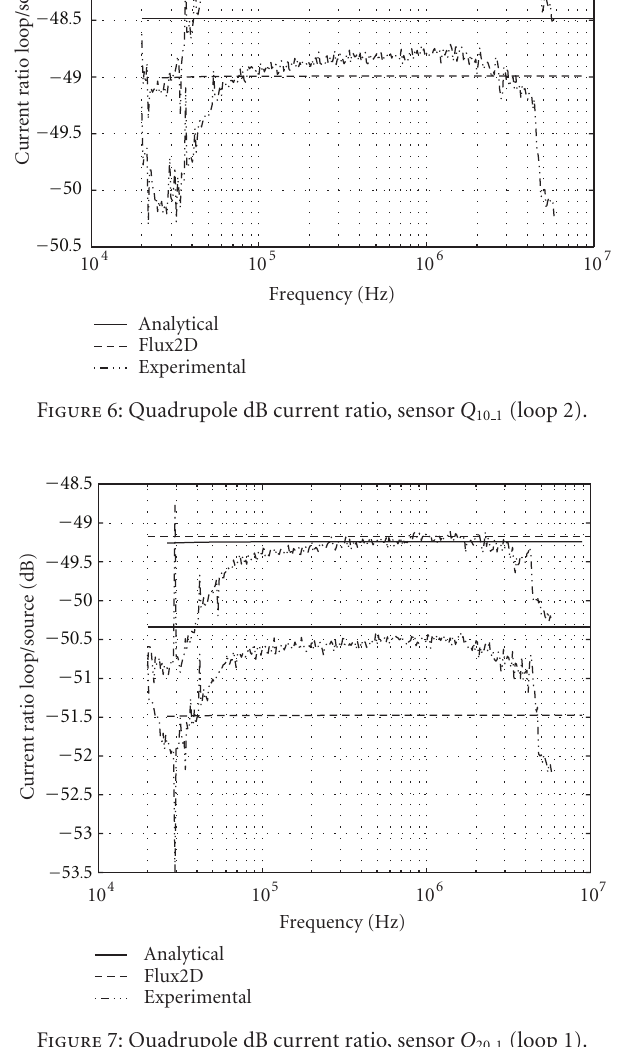
Figure 7: Quadrupole dB current ratio, sensor Q 20 1 (loop 1).